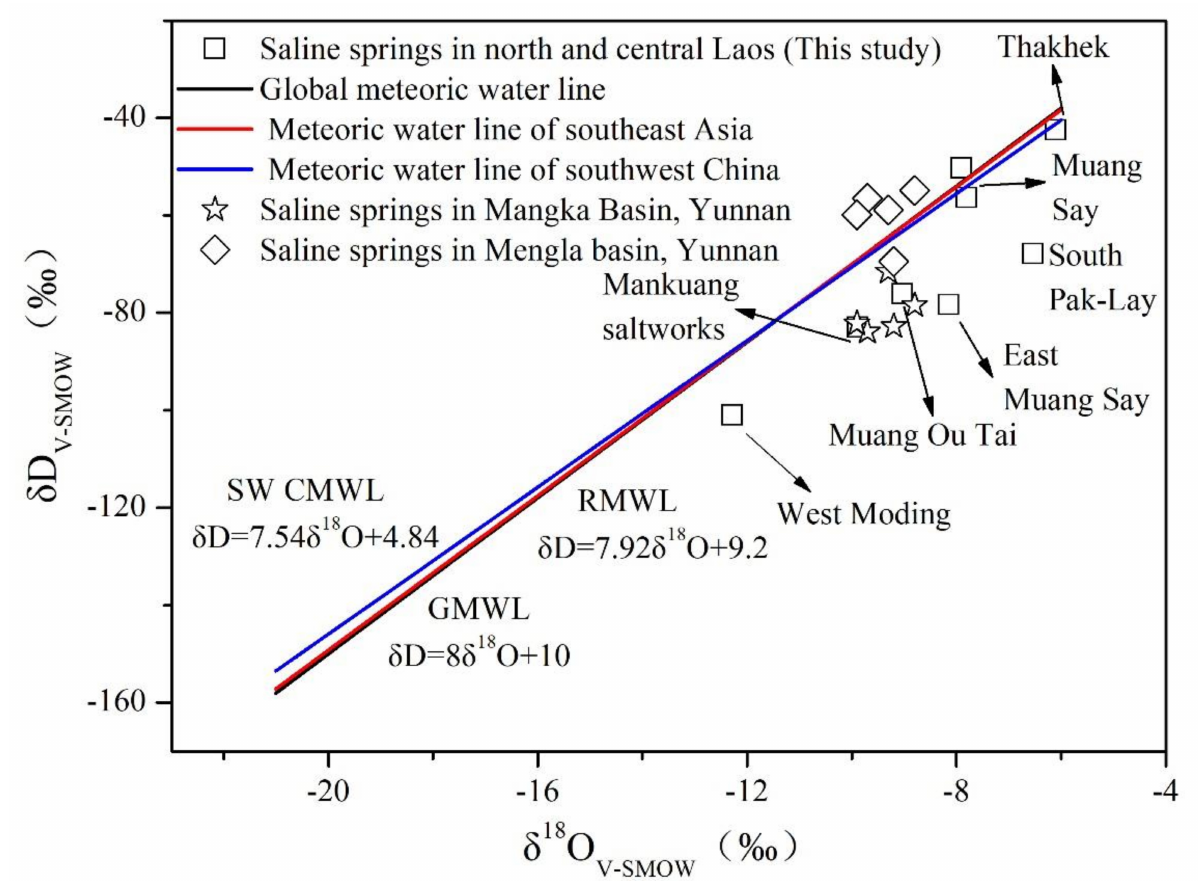
Figure 3. Isotope composition ( δ D and δ 18 O) of the saline springs in north and central Laos plotted against the GMWL, the SW CMWL, and the RMWL, the comparison area date from